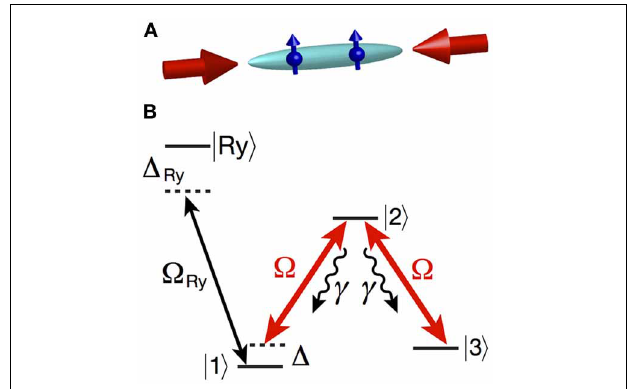
FIGURE 1 | Setup of the system. (A) Ultracold atoms are confined in a one-dimensional optical trap. Two counter-propagating laser beams drive the electronic transitions with a Rabi frequency (cid:2) . (B) Internal level structure of the atoms. Two components of the ground electronic state, | 1 (cid:3) and | 3 (cid:3) , are coupled to an electronically excited state, | 2 (cid:3) , spontaneously decaying with a rate γ . The laser field coupling states | 1 (cid:3) and | 2 (cid:3) is detuned from the resonance by (cid:3) ; state | 1 (cid:3) is provided with an effective dipole moment, d , via far-off-resonant Rydberg dressing, (cid:3) Ry (cid:5) (cid:2) Ry . States | 2 (cid:3) and | 3 (cid:3) are